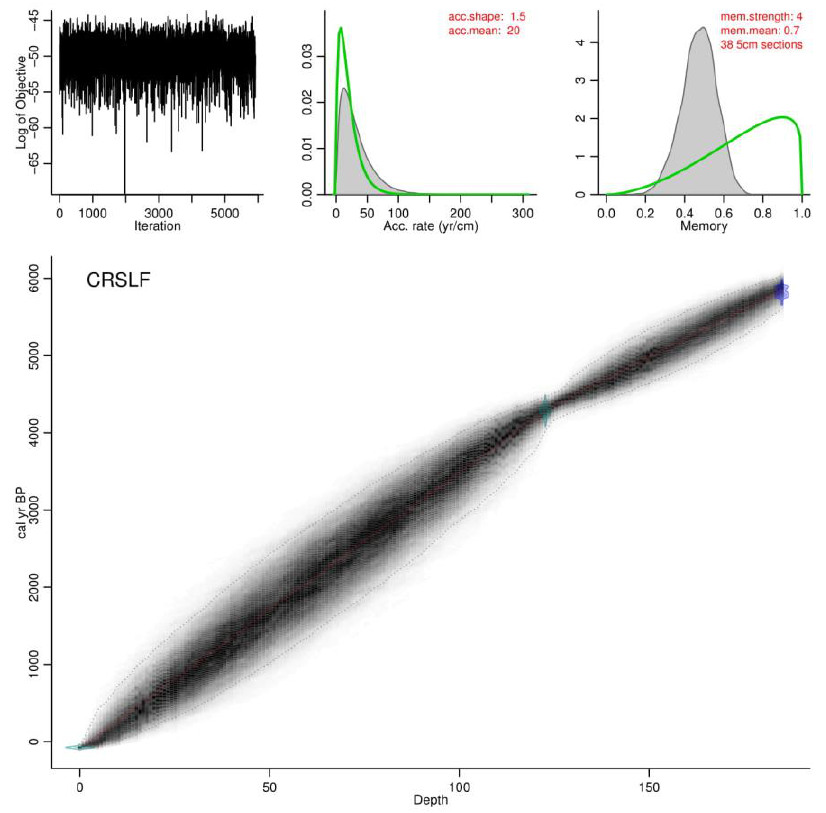
Figure A3g. Age-depth model produced in BACON for CRSLF.